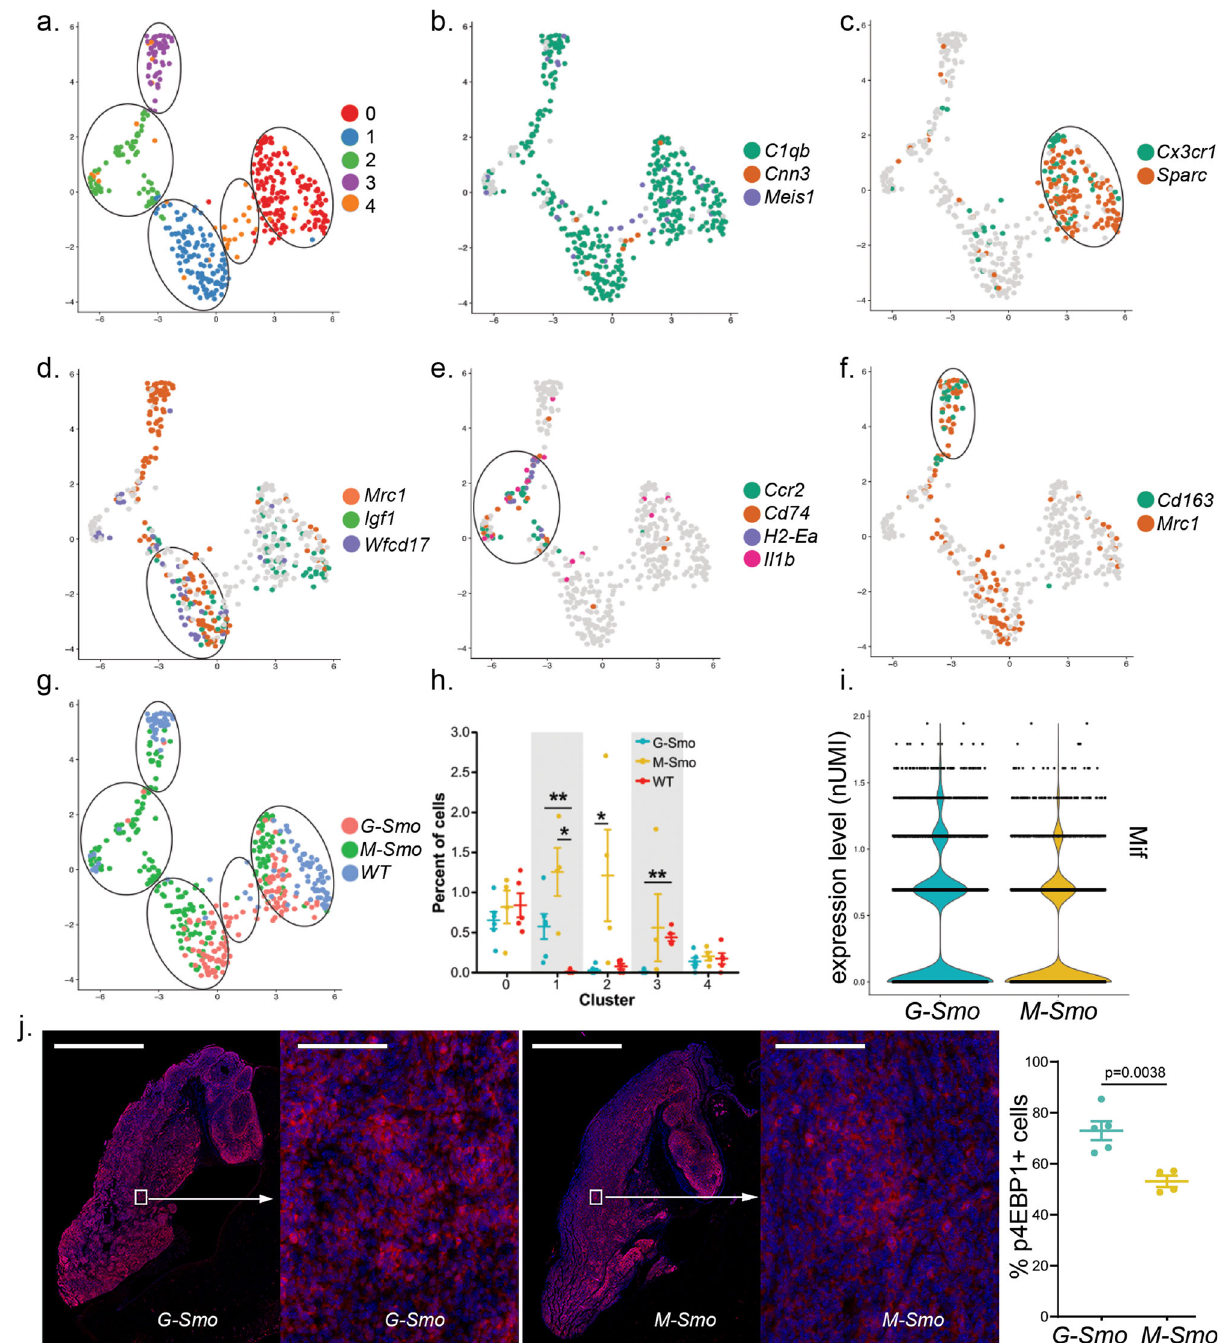
Fig. 6 M-Smo tumors show macrophage and microglial populations not present in G-Smo tumors. a UMAP showing myeloid-like cells from G-Smo , M- Smo, and P7 WT, with clusters color-coded and circled. b Feature plot on UMAP from a , showing expression of the pan-macrophage and microglial marker C1qb and the choroid plexus epithelial markers Cnn3 and Meis1 . Cluster 4 does not show C1qb expression. c – f Feature plots on UMAP from a , showing expression of c Cluster M 0 markers Cx3cr1 and Sparc , d Cluster M 1 markers Igf1, Mrc1 , and wfdc17 , or e Cluster M 2 markers Ccr2 , Cd74 , H2-Ea-ps , and Il1b f Cluster M 3 markers Mrc1 and Cd163 . g genotype color-coded on the UMAP from a . Circles indicate the positions of the clusters. h Comparison of the indicated cluster populations in G-Smo , M-Smo , and P7 WT. i Violin plots showing the number of cells expressing the indicated level of Mif in each genotype. j IHC for p4EBP1 in representative G-Smo and M-Smo tumors at low and higher magni fi cation, and quanti fi cation of p4EBP1 + fractions of tumor cells in each genotype. Scale bars = 2 mm in low magni fi cation images and 200 µ m in higher magni fi cation images. Student ’ s test was used in h , j and two- proportions z -test in i . In graphs in h and j , dots represent values for individual replicates, bars indicate the means and whiskers indicate the